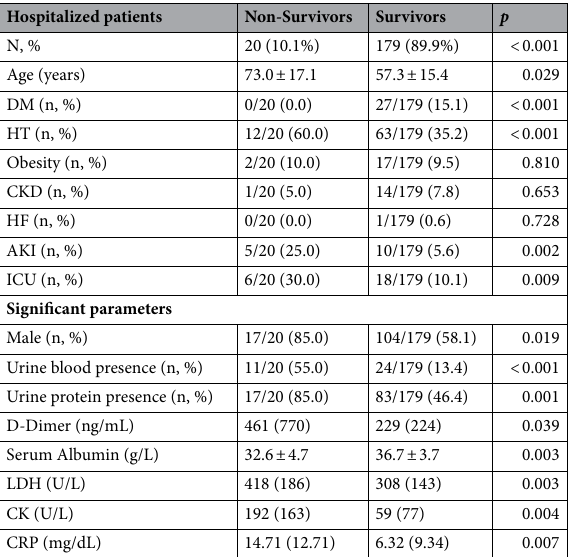
Table 5. Clinical data and biochemical results for survivors and non-survivors COVID-19 patients. Quantitative variables were described by mean ± standard deviation or median (IQR); DM, Diabetes; HT, Hypertension; CKD, Chronic kidney disease; HF, heart failure; ICU, Intensive Care Unit; AKI, Acute Kidney Injury; LDH, lactate dehydrogenase; CK, creatine kinase; CRP, C-reactive